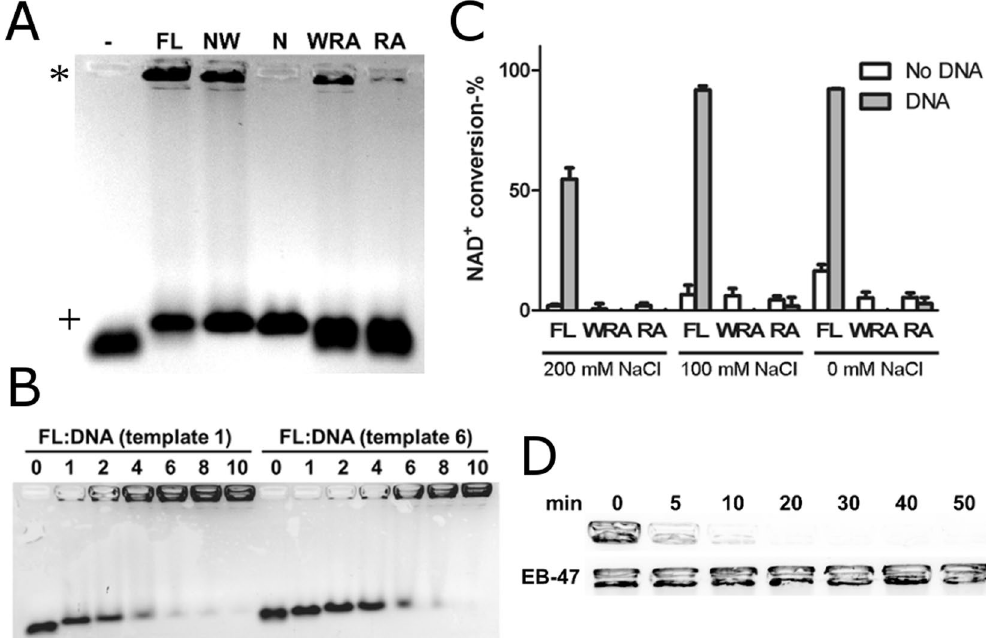
Figure 2. Characterization of DNA-binding properties and DNA-dependent activation of Tb PARP. ( A ) The binding of T b PARP constructs (2 µ M) to DNA template 1 (0.5 µ M) were evaluated with agarose gel electrophoresis. ( * ) Shows the position of the supershifted DNA and ( + ) displays the smaller DNA shift. ( B ) Concentration-dependent analysis of DNA binding to TBP-FL. TBP-FL was titrated against 0.5 µ M DNA (templates 1 and 6) and analyzed with agarose gel electrophoresis. ( C ) DNA dependent activation of TBP-FL, TBP-WRA and TBP-RA using different salt concentrations. Activated DNA was used as a template. ( D ) DNA dissociation from TBP-FL followed by automodification was evaluated as a function of time with agarose gel electrophoresis either without (upper lane) or with (lower lane) inhibitor EB-47 (10 µ